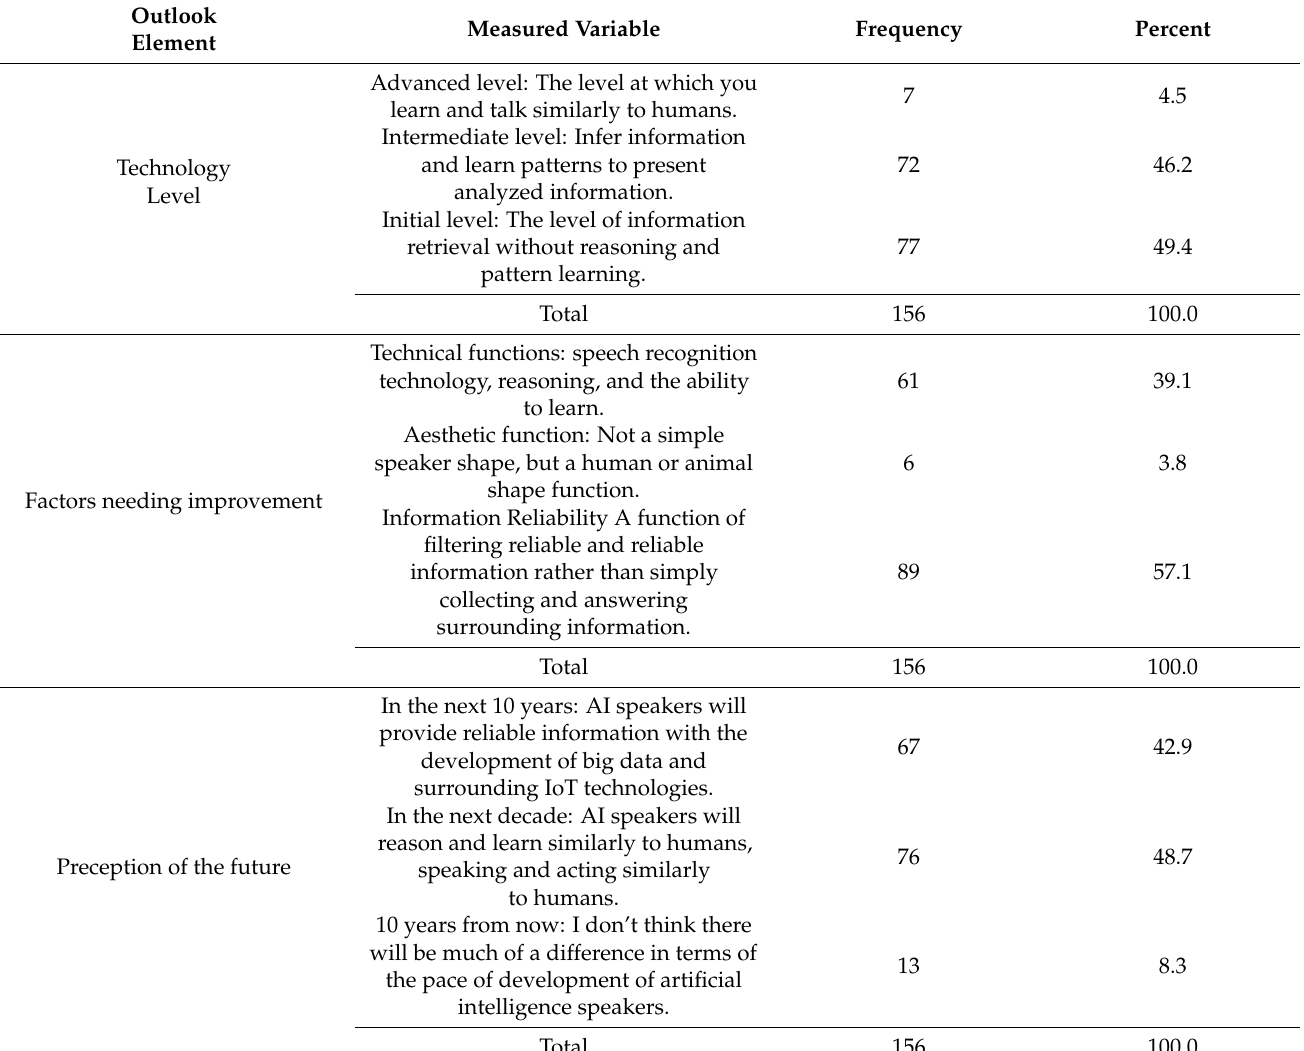
Table 3. Analysis result of technology level, improvement items, and perception of the future.